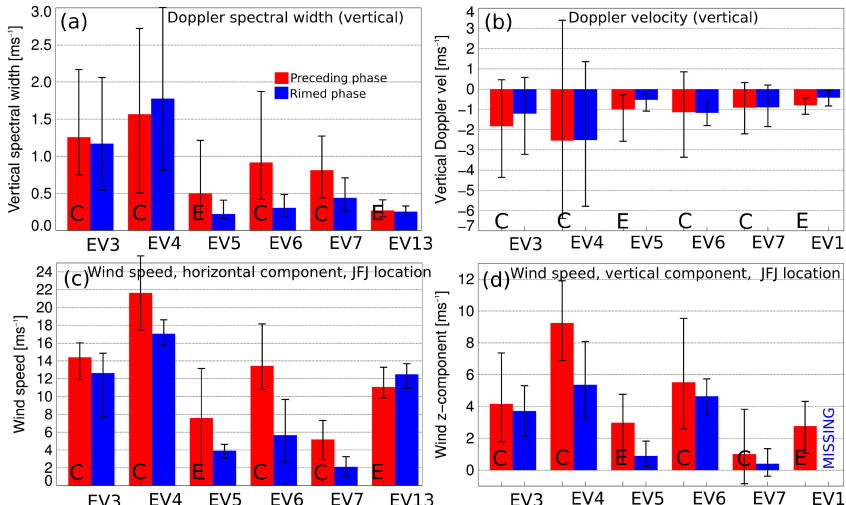
Figure 4. Measurements of wind, turbulence, and fall velocities before (red histograms) and during (blue histograms) the six “rimed phases” shown in Fig. 3. Panels (a) and (b) show radar data (only for altitude around the JFJ location: 3580 ± 100m), while panels (c) and (d) show data collected at the JFJ location. (a) Doppler spectral width (ms − 1 ) from radar vertical profiles (i.e., at vertical incidence). (b) Doppler velocity (ms − 1 ) from radar vertical profiles. (c) Wind speed (data from MeteoSwiss station) (ms − 1 ). (d) Vertical component of the wind (sonic anemometer data) (ms − 1 ). The error bars highlight the location of the 5 and 95% quantiles, respectively.